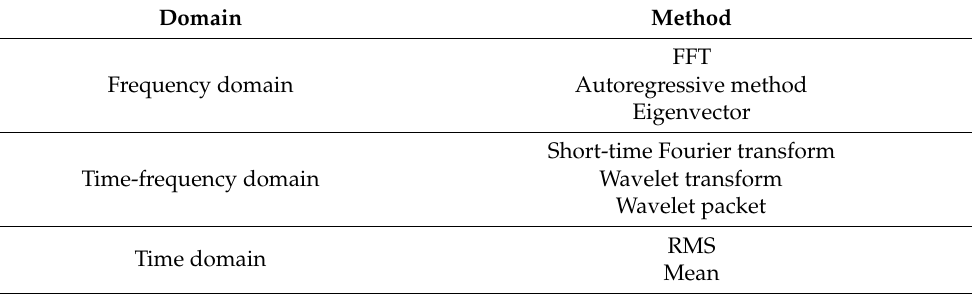
Table 1. EMG analysis methods.